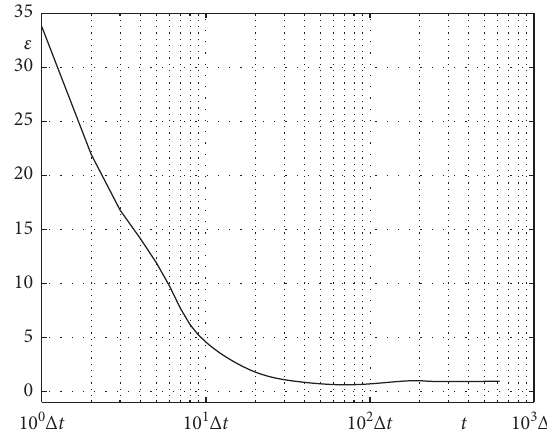
Figure 10: Temporal evolution of the objective function E with respect to the iteration of the algorithm for the “Romeo and Juliet” case.